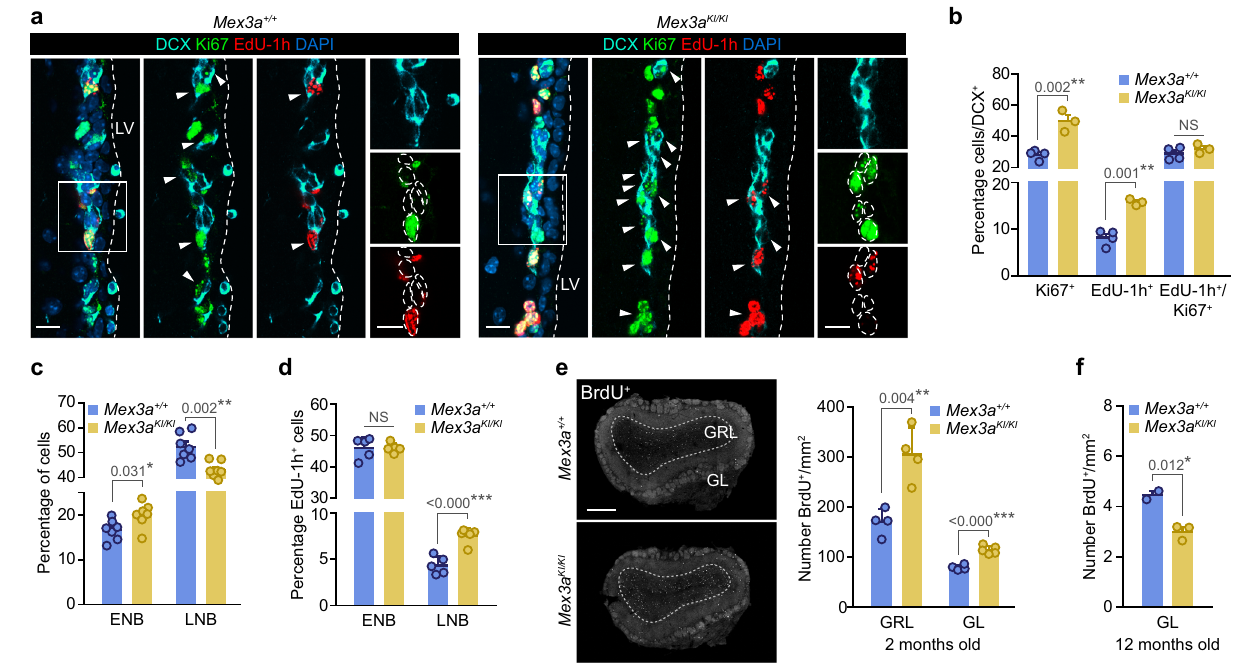
Fig.6|MEX3AisagatekeeperfortimelycellcycleexitofNBwithanimpacton adult neurogenesis. a Representative images of DCX (cyan) immunostaining in combinationwithKi67(green)andEdU-1h(red)in Mex3a +/+ and Mex3a KI/KI adultSEZ sections. b Quanti fi cation of the percentage of Ki67 + cells, EdU-1h + cells and the ratio EdU-1h + /Ki67 + in DCX + NBs (NS=0.311). c Quanti fi cation of the percentage of ENB and LNB populations by FACS. d Quanti fi cation of the percentage of EdU- labeled cells among NB populations after a one-hour pulse analyzed by FACS (NS=0.895). e Immunohistochemistry for BrdU (white) in the OB of young adult mice (left panel). Quanti fi cation of the number of BrdU-28 days + neurons reaching the granular (GRL) and glomerular (GL) layer of the OB in Mex3a +/+ and Mex3a KI/KI